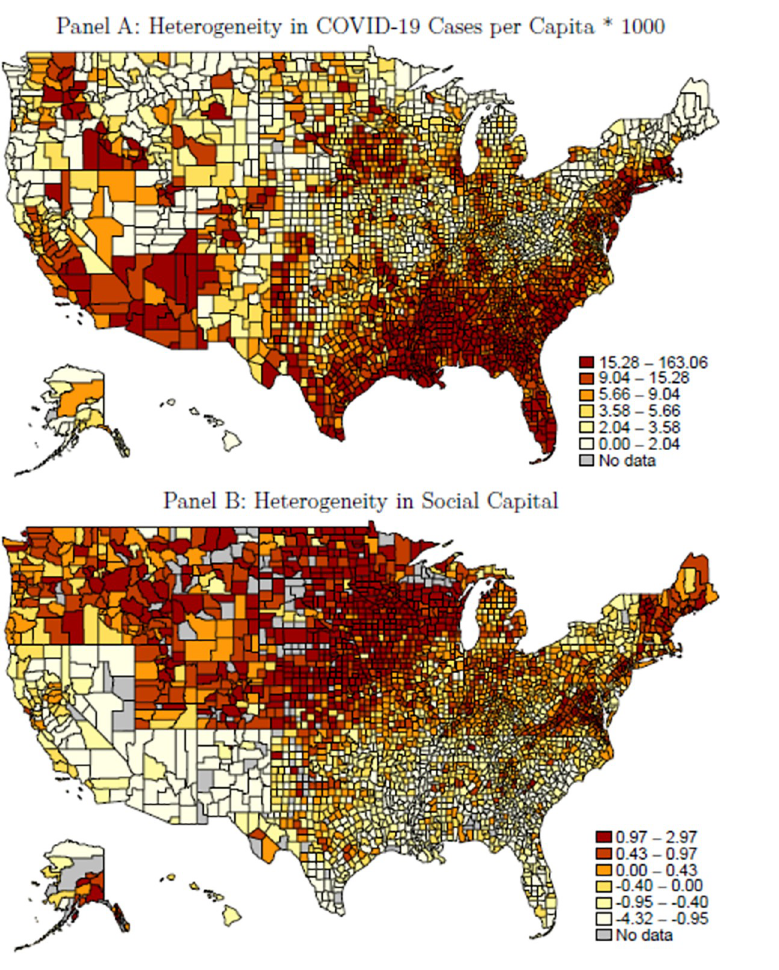
Fig 2. Spatial heterogeneity in infections per capita and social